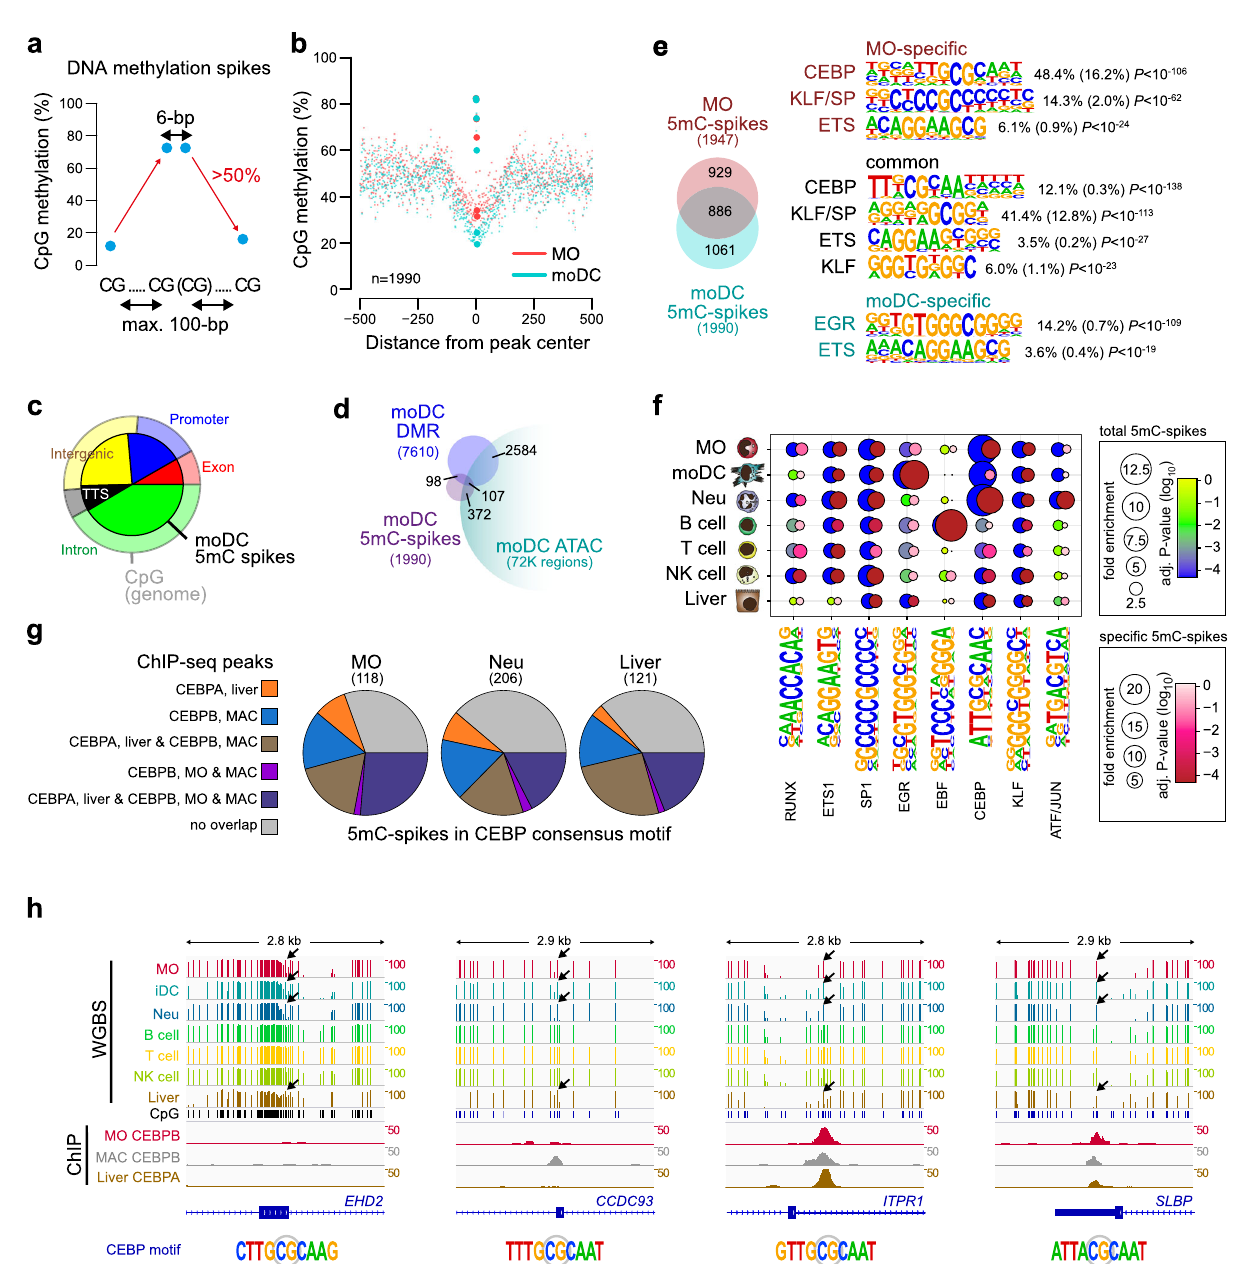
Fig. 7 DNA methylation-spikes are cell-type-speci fi c and enriched for TF motifs. a Strategy for identifying small (maximum 6-bp wide) spikes of DNA methylation. b Genomic distance distribution of averaged DNA methylation ratios in MO and moDC across moDC 5mC-spikes. Values of central CpGs are indicated by larger dots and the number of 5mC-spikes is given in the lower left corner. c Pie chart illustrating the genomic location distribution of moDC 5mC-spikes (inner circle) relative to CpGs across the entire genome. d Venn diagram depicting the overlap between 5mC-spikes, DMR, and accessible regions (ATAC peaks) in moDC. e Venn diagram indicating the number of common and cell-type-speci fi c 5mC-spikes between MO and moDC. De novo – derived motifs for each 5mC-spike set are given along with the signi fi cance of motif enrichment (hypergeometric test) and the fraction of motifs in peaks (background values are in parenthesis). Top motifs corresponding to known factor families are shown for each set. f Balloon plot depicting the motif enrichment of selected motifs across all 5mC-spikes identi fi ed in each cell type (blue-green-yellow coloring according to corrected enrichment P -value) or cell-type-speci fi c 5mC-spikes (red-pink-white coloring according to corrected enrichment P -value). The balloon size represents the fold-enrichment and the coloring indicates the corrected P -value (hypergeometric test, Benjamini-Hochberg multiple testing correction) of the motif occurrence in 5mC-spikes. g Pie charts illustrating the overlap of 5mC-spikes with the indicated CEBP factor ChIP-seq peaks in MO, MAC, and liver. h IGV genome browser tracks for the indicated WGBS and ChIP data sets at example regions around 5mC-spikes overlapping the CEBP consensus sequence. ( b , c , f , g ) Source data are provided as a Source Data fi